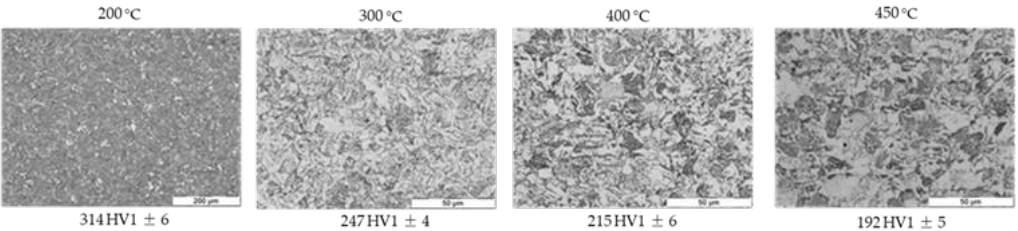
Figure 5. Microstructure and Vickers hardness obtained in in-die bainitizing trials at different tool temperatures.